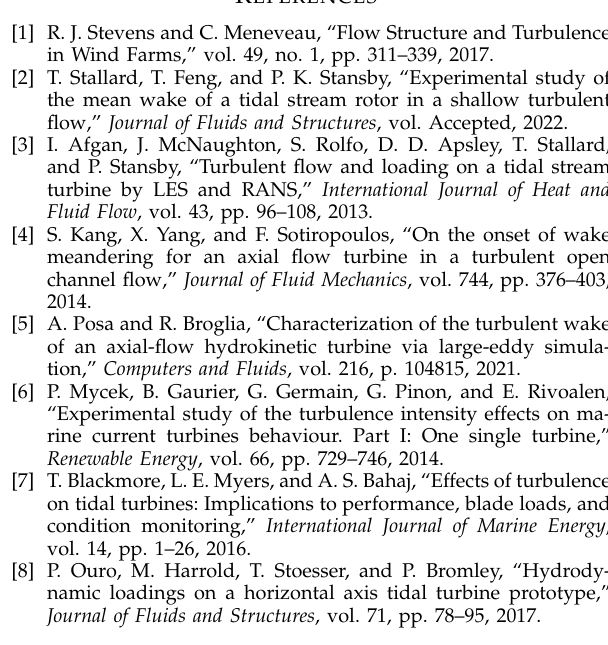
eter of the turbine) lower than approx. 2.0 due to